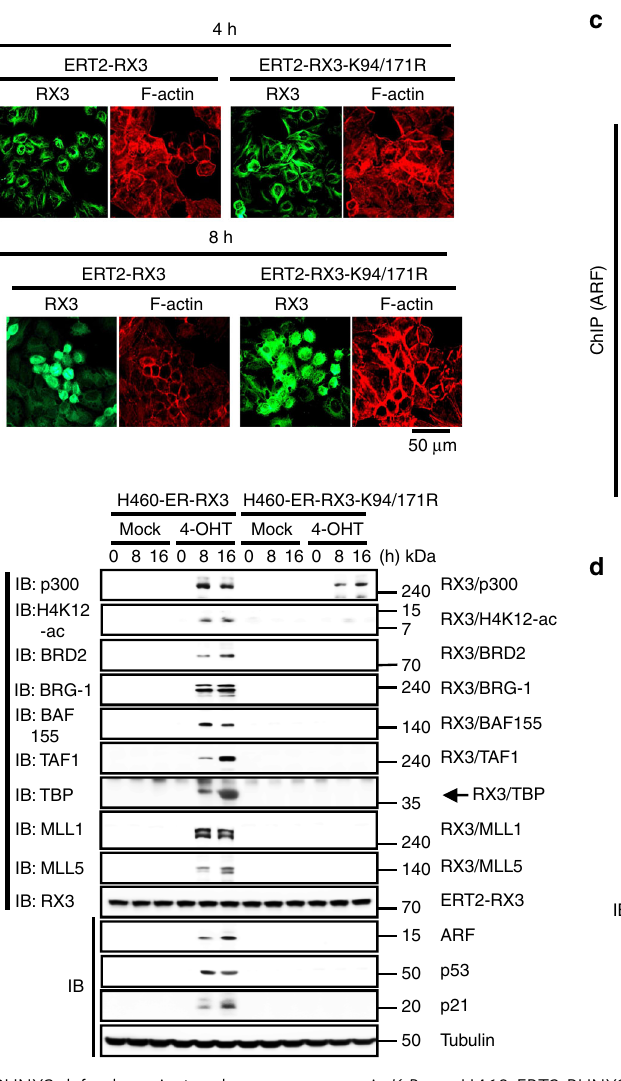
Fig. 9 RUNX3 defends against endogenous oncogenic K-Ras. a H460-ERT2-RUNX3 and H460-ERT2-RUNX3-K94/171R cells were synchronized by serum deprivation and stimulated with 10% serum and 1 μ M 4-OHT for the indicated durations (0, 4, and 8 h). Time-dependent subcellular localization of the expressed proteins was analyzed by double immuno fl uorescence staining (green = RUNX3; red = F-actin). b , c H460-ERT2-RUNX3 and H460-ERT2- RUNX3-K94/171R cells were serum-starved for 24 h, stimulated with 10% serum or 10% serum + 1 μ M 4-OHT. Cells were harvested at the indicated time points, and the time-dependent interactions of RUNX3 with BRD2, p300, H4K12-ac, TFIID complex (TAF1, TAF7, and TBP), SWI/SNF complex (BRG-1 and BAF155), and MLL1/5 were measured by IP and IB. Expression of p14 ARF , p53, and p21 was measured by IB. The binding of the proteins and H4K12-ac, H3K27-me3, and H3K4-me3 to the ARF promoter was measured by ChIP at the indicated time points. One-thirtieth of the lysates were PCR-ampli fi ed as input samples. d H460-vec, H460-ERT2-RUNX3, and H460-ERT2-RUNX3-K94/171R cells were treated with indicated si-RNA, serum-starved for 24 h, and then stimulated with 10% serum or 10% serum + 1 μ M 4-OHT for the indicated durations. Apoptotic cells were detected by fl ow cytometry after Annexin V – FITC/PI staining. The levels of p53 were measured by